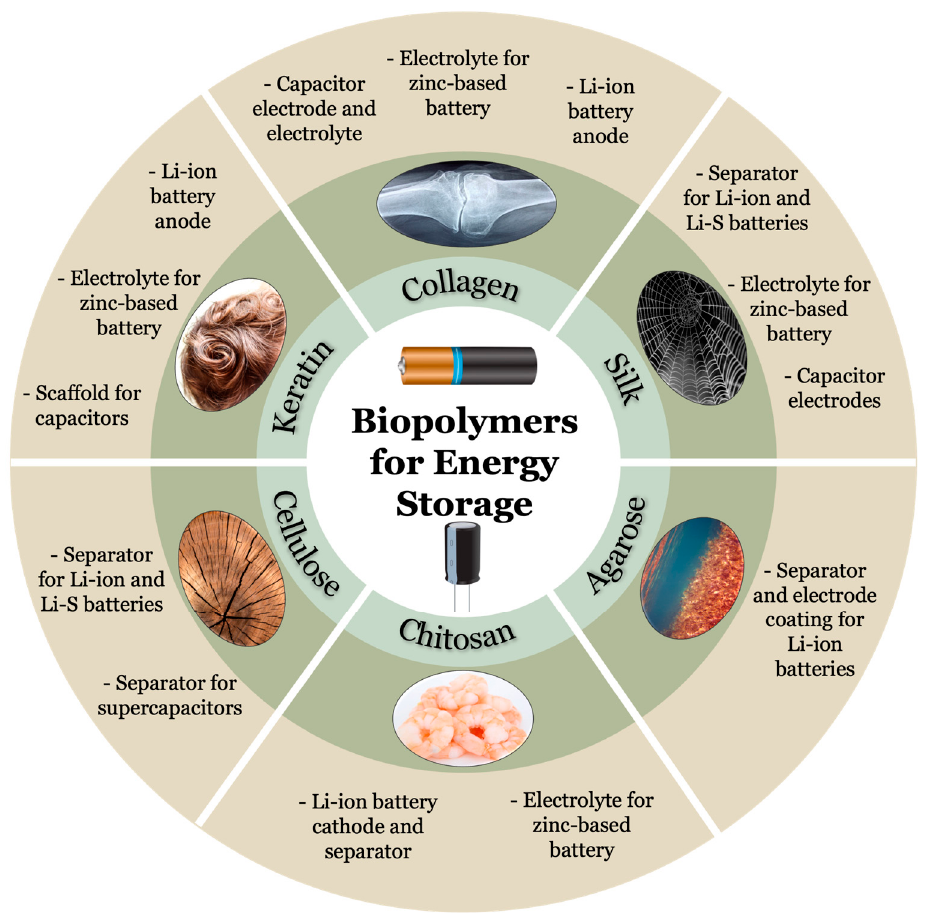
Figure 2. Source and applications for biopolymers commonly utilized for energy storage purposes such as batteries and capacitors. Keratin, collagen, and silk are protein-based biopolymers while cellulose, chitosan, and agarose are polysaccharide-based biopolymers. (Images of biopolymers were obtained with permission from pixabay.com, accessed on 1 December 2022).